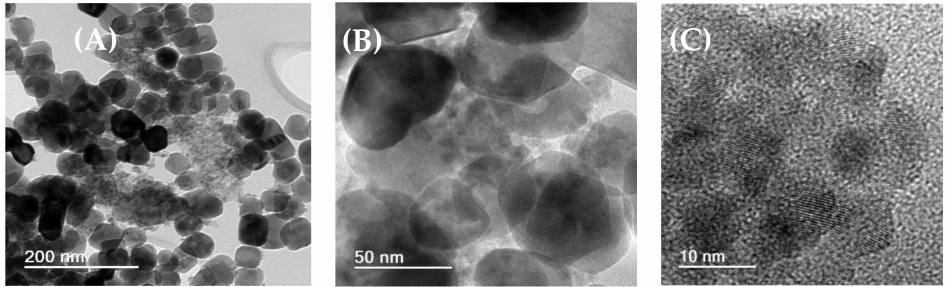
Figure 2. TEM images of CdSeS/ZnSQDs/BTO at three different scales: ( A ) 200 nm, ( B ) 50 nm, and ( C ) 10 nm.